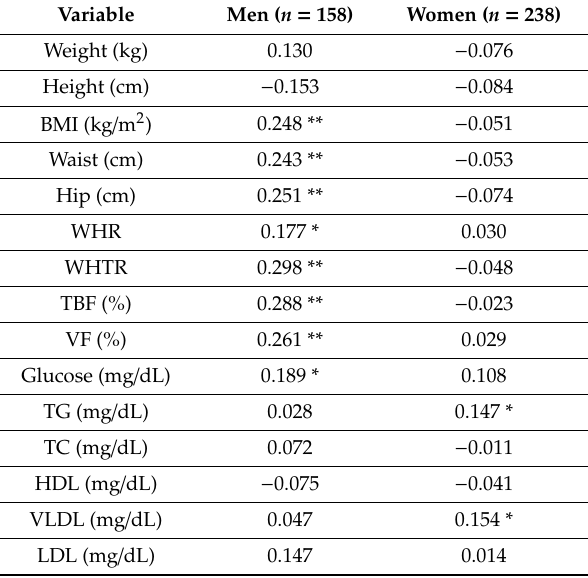
Table 3. Correlations between the anthropometric and metabolic variables and CSD consumption according to